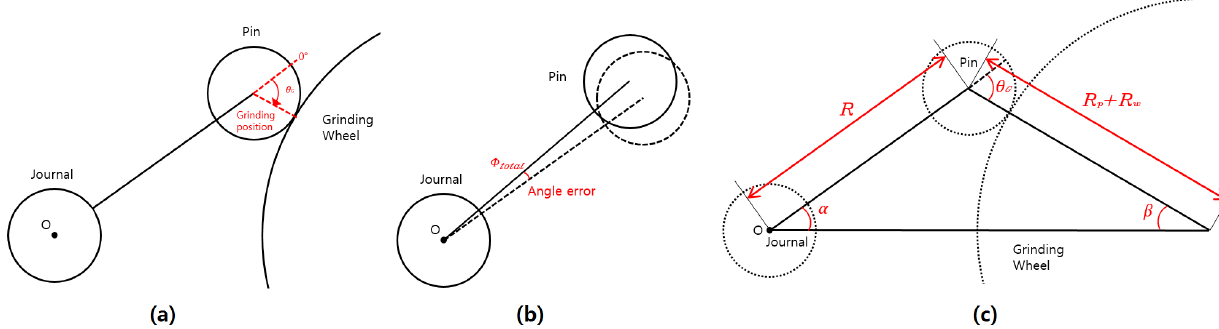
Figure 3. Diagrammatic view of non-circular